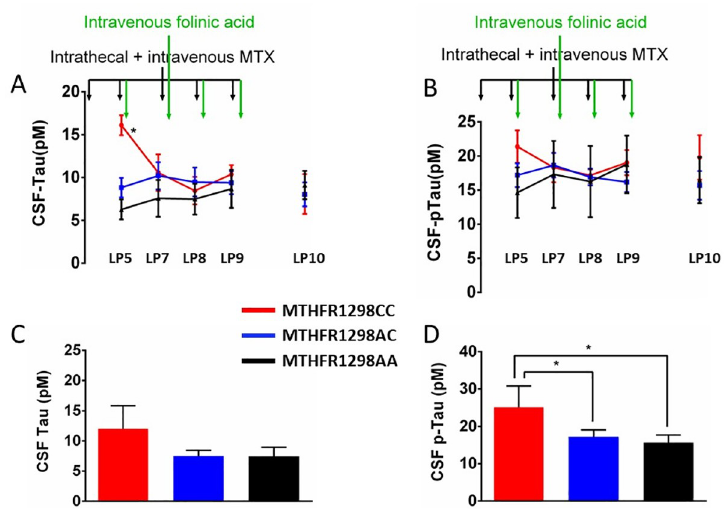
Fig 3. During the latter treatment phases, intravenous folinic acid administration reduced the highly elevated CSF levels of Tau (but not pTau) in methylenetetrahydrofolate reductase (MTHFR) MTHFR1298CC individuals. Methotrexate (MTX) treatment was continued (black vertical arrows at the top of each figure). Panels A-B depict CSF Tau (A) and pTau (B) levels during the interval and reinduction phases (lumbar puncture, LP6-10). Initially elevated CSF Tau (but not pTau) levels (LP6), equalized after intravenous folinic acid administration (LP7-10, green vertical arrows). Panels C-D depict CSF biomarker levels during the maintenance phase. CSF pTau differed significantly between genotypes (D), whereas Tau did not (C). MTHFR genotype is indicated with color in all panels (red: MTHFR1298CC, blue: MTHFR1298AC, black: MTHFR1298AA). Appropriate ANOVA was followed by post-hoc LSD with � p < 0.05; �� p < 0.010; ��� p < < 0.001.